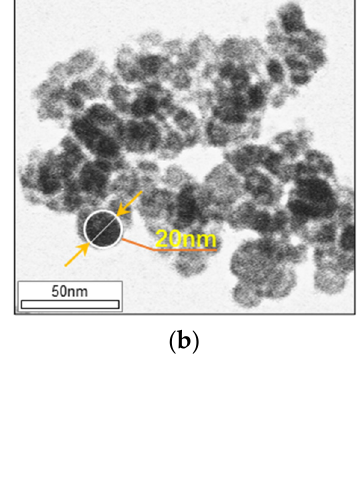
Figure 1. ( a ) X-ray diffraction pattern of Fe 3 O 4 /MnO 2 (the green line represents the XRD of Fe 3 O 4 /MnO 2 , the red lines represent the characteristic peaks of Fe 3 O 4 , and the black lines represent the characteristic peaks of α -MnO 2 ); ( b ) EDX of Fe 3 O 4 /MnO 2 .